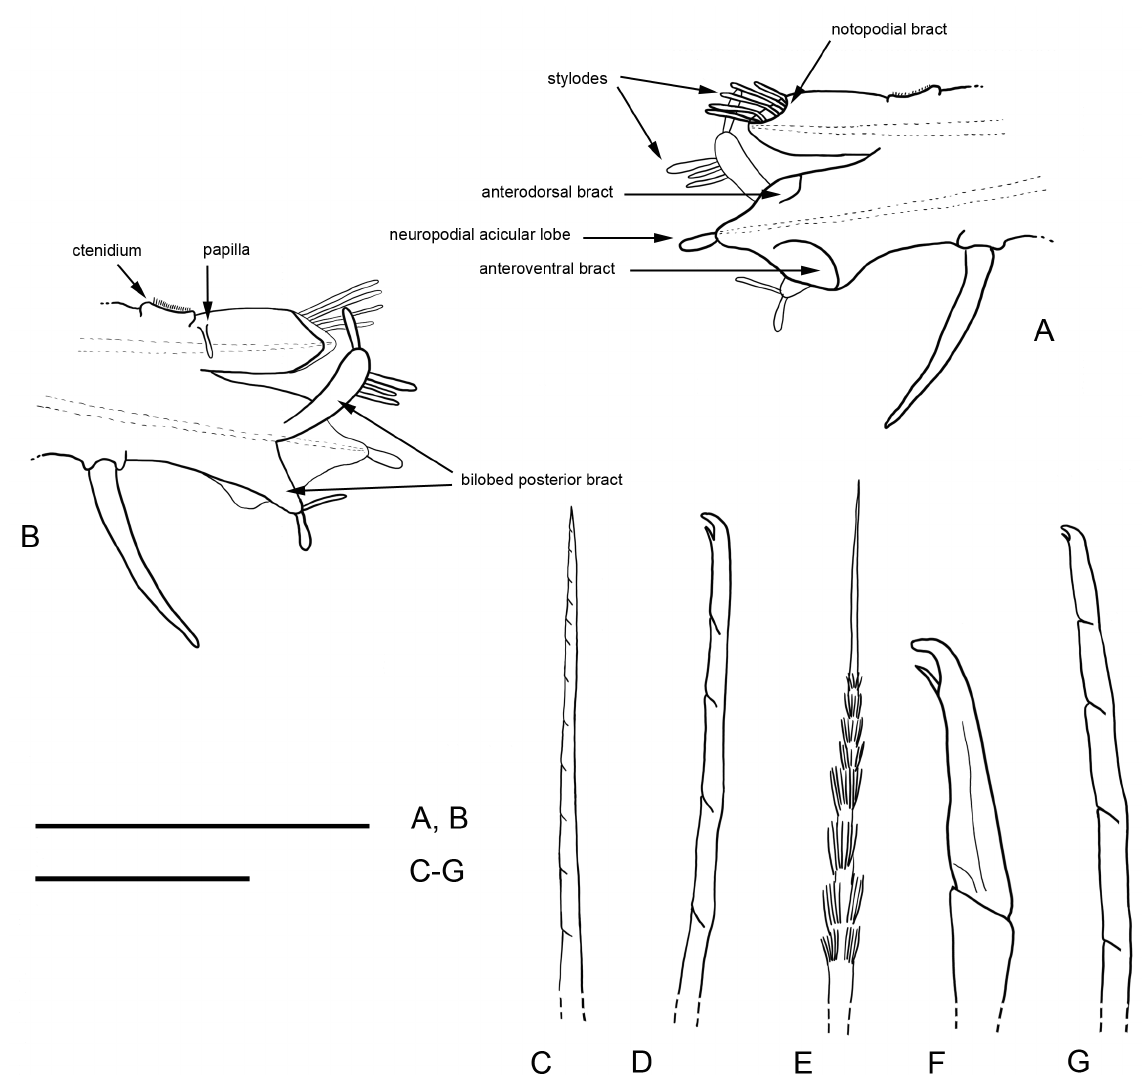
Fig. 2. Sthenelais limicola (Ehlers, 1864). TUM 37563. A . Right parapodium of segment 8; anterior view. B . Same, posterior view. C–G . Neurochaetae of segment 23, all distal part. C . Upper compound spiniger. D . Upper slender compound falciger. E . Upper simple, spinous neurochaeta. F . Middle stout compound falciger. G . Lower slender compound falciger. Scale bars: A–B = 500 µm; C–G =